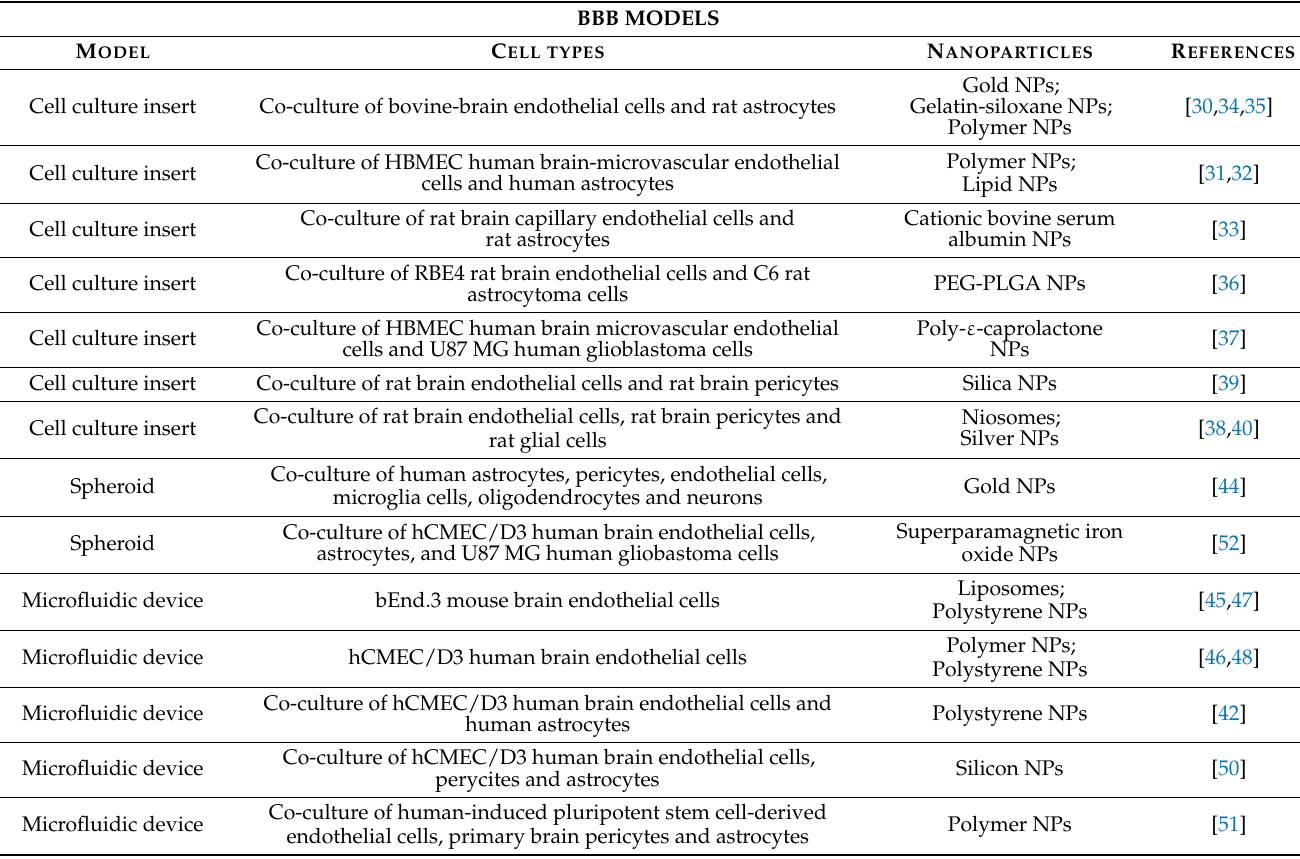
Table 1. Summary of in vitro BBB models used for nanomedical